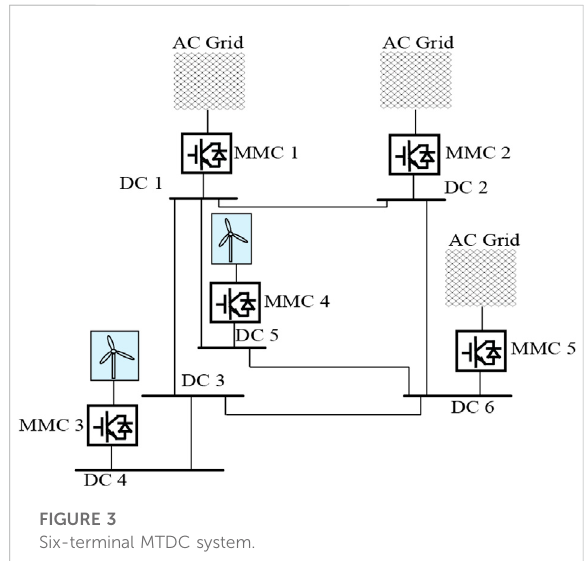
FIGURE 3 Six-terminal MTDC